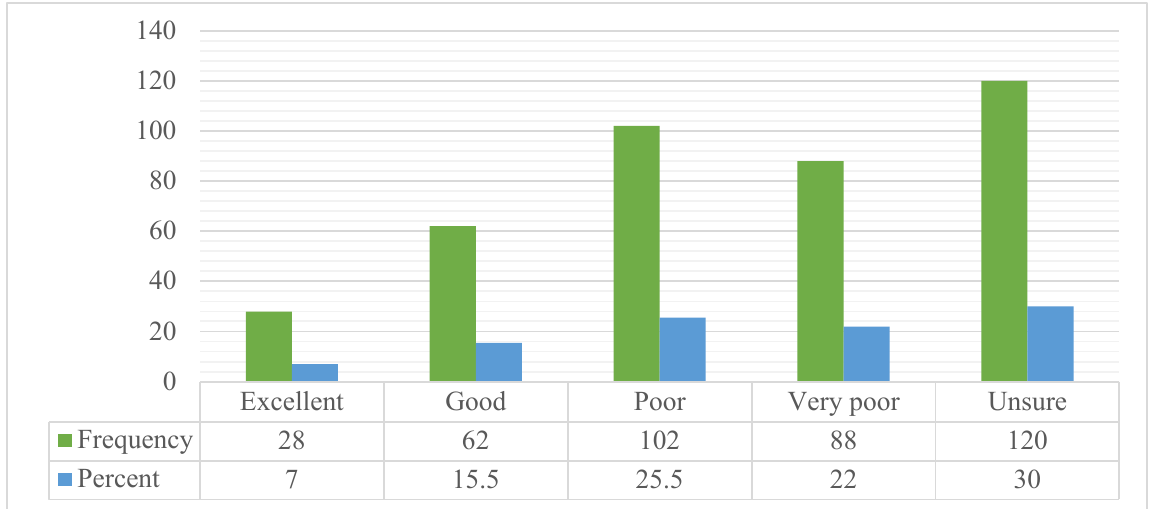
Figure 2. The Level of Community Participation based on the Mechanisms. Source (Mamokhere and Meyer 2022).